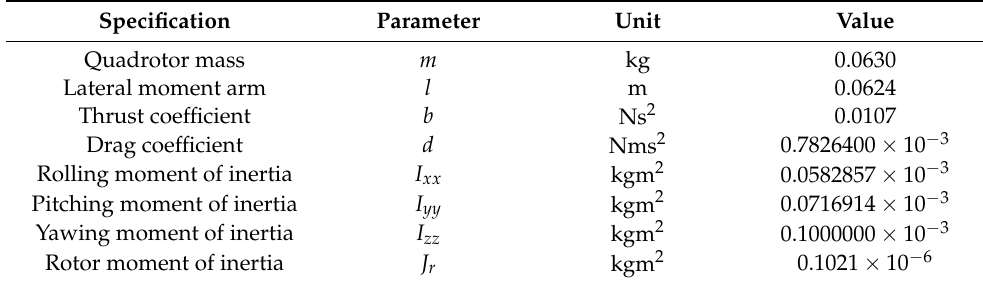
Table 1. Parrot Mambo Model Physical Parameters